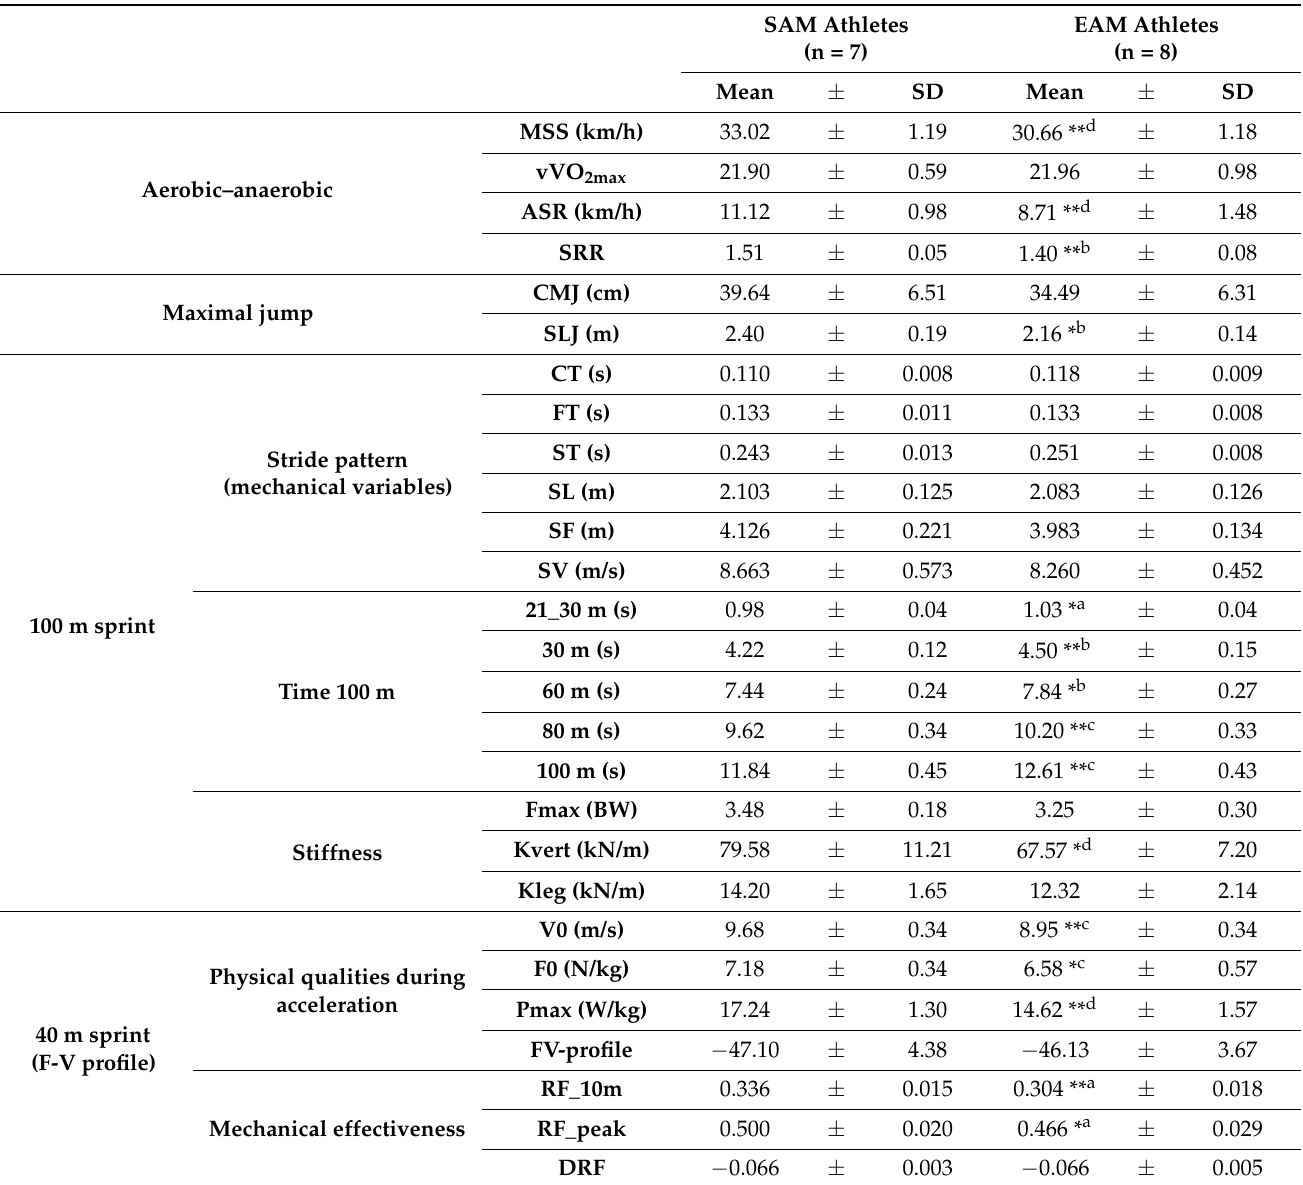
Table 2. Aerobic–anaerobic variables, sprint and jump performance, and sprint mechanical character- istics of participants in the